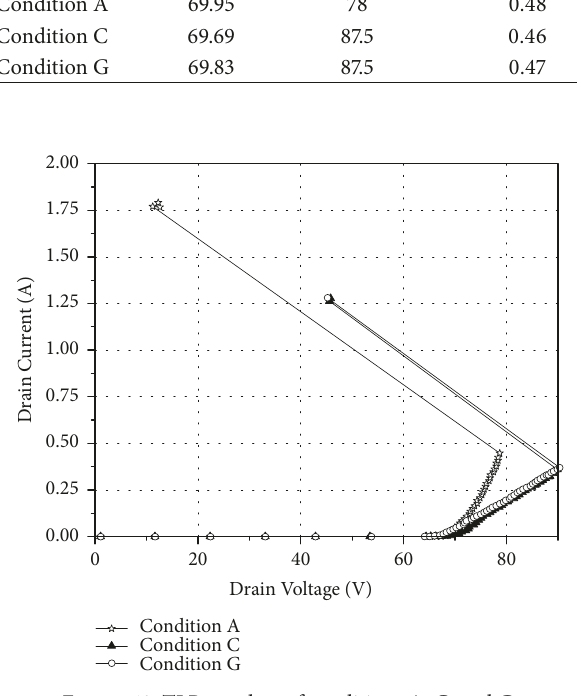
Figure 12: TLP test data of conditions A, C, and